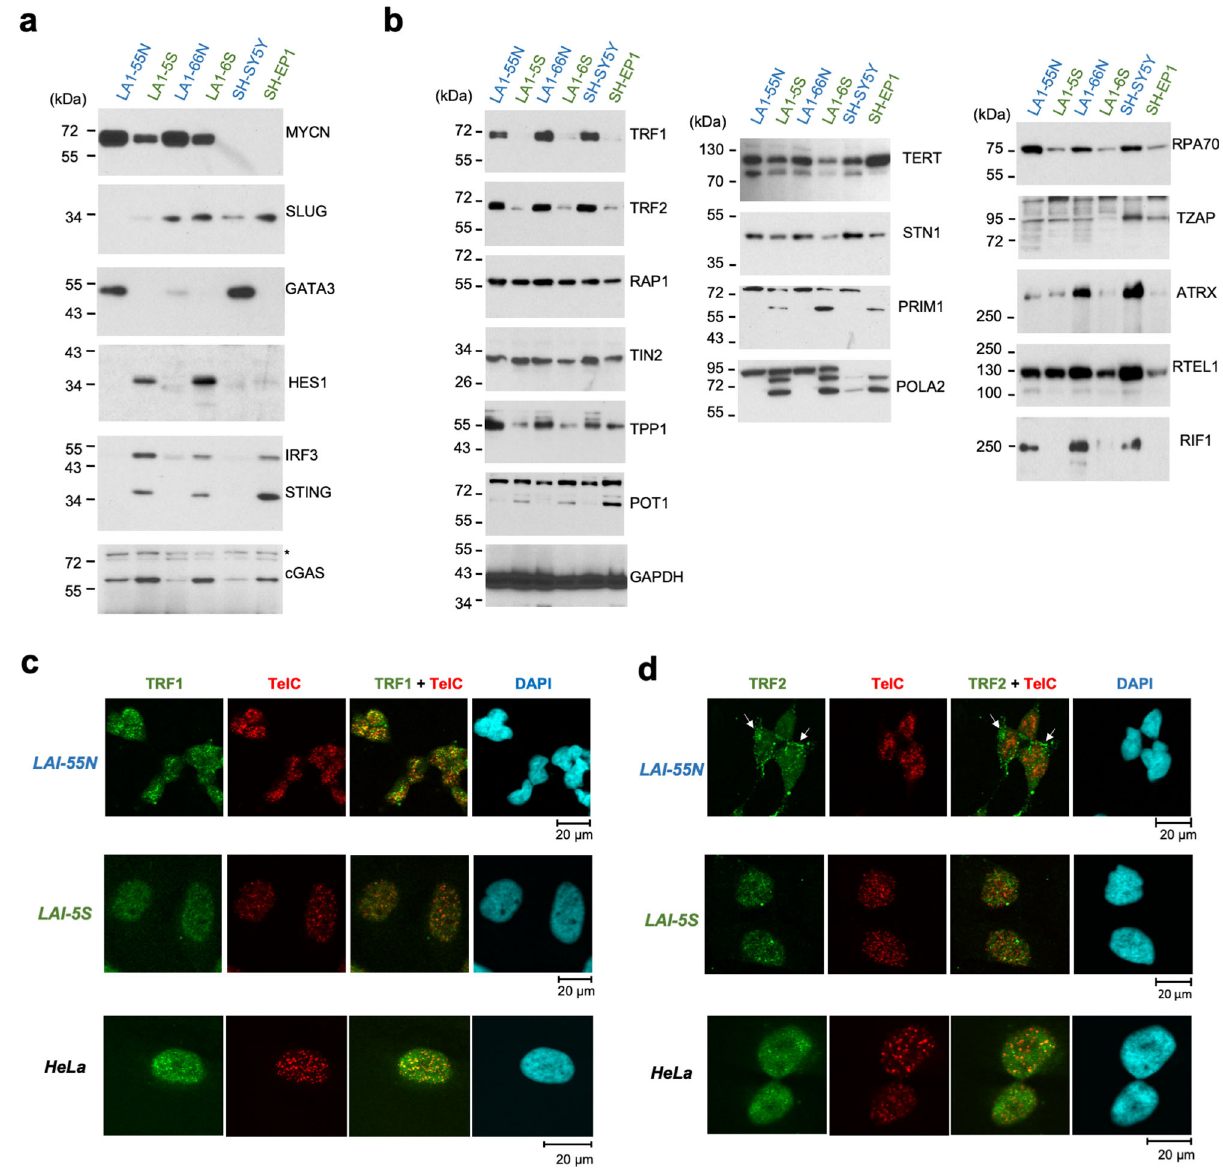
Fig. 1 Matched ADRN and MES cell lines show prominent differences in telomere protein expression and localization. a and b Western analysis of cell lineage, DNA sensing, and telomere-related factors in three matched ADRN and MES cell lines. The LA1-55N (ADRN) and LA1-5S (MES) pair, as well as the LA1-66N (ADRN) and LA1-6S (MES) pair, were both derived from LAN-1, a MYCN-ampli fi ed NB tumor. The SH-SY5Y (ADRN) and SH-EP1 (MES) pair was derived from a non-MYCN-ampli fi ed tumor. ADRN and MES cell line names are displayed in blue and green, respectively, in all fi gures in this study. c and d IF-FISH analysis of TRF1 and TRF2 in the indicated cell lines. Prominent examples of peri-nuclear staining of TRF2 in LA1-55N are marked with white